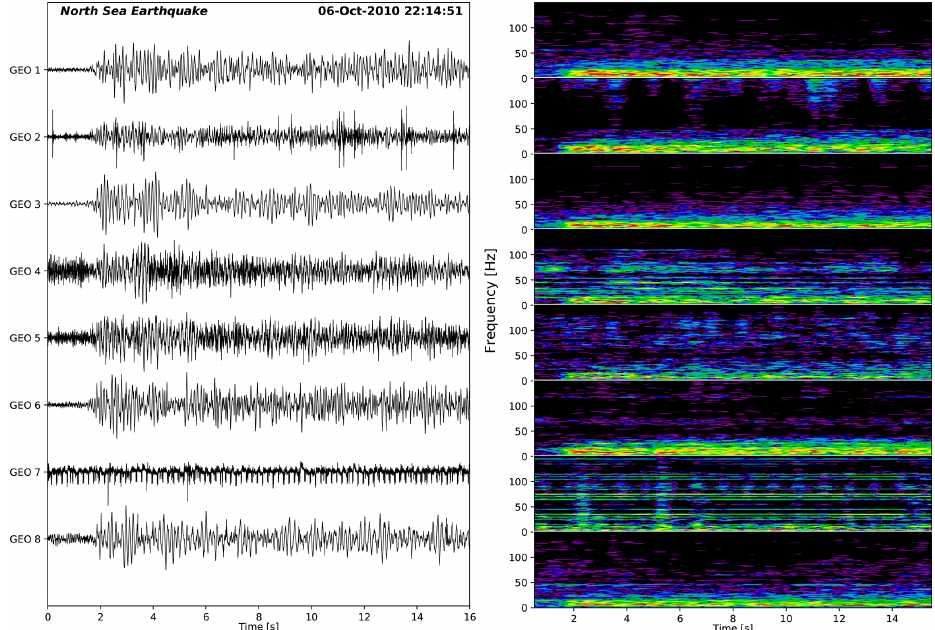
Figure B9. Example of a regional earthquake of magnitude M 2 . 7 located in the North Sea, SW of Åknes. Due to the distance of the hypocentre to the stations, only the P-wave arrival is visible on the 16s long records. Waveforms recorded on geophones 2 and 4 are noisy and show greater variability compared to the other waveforms. Geophone 7 was not functional.